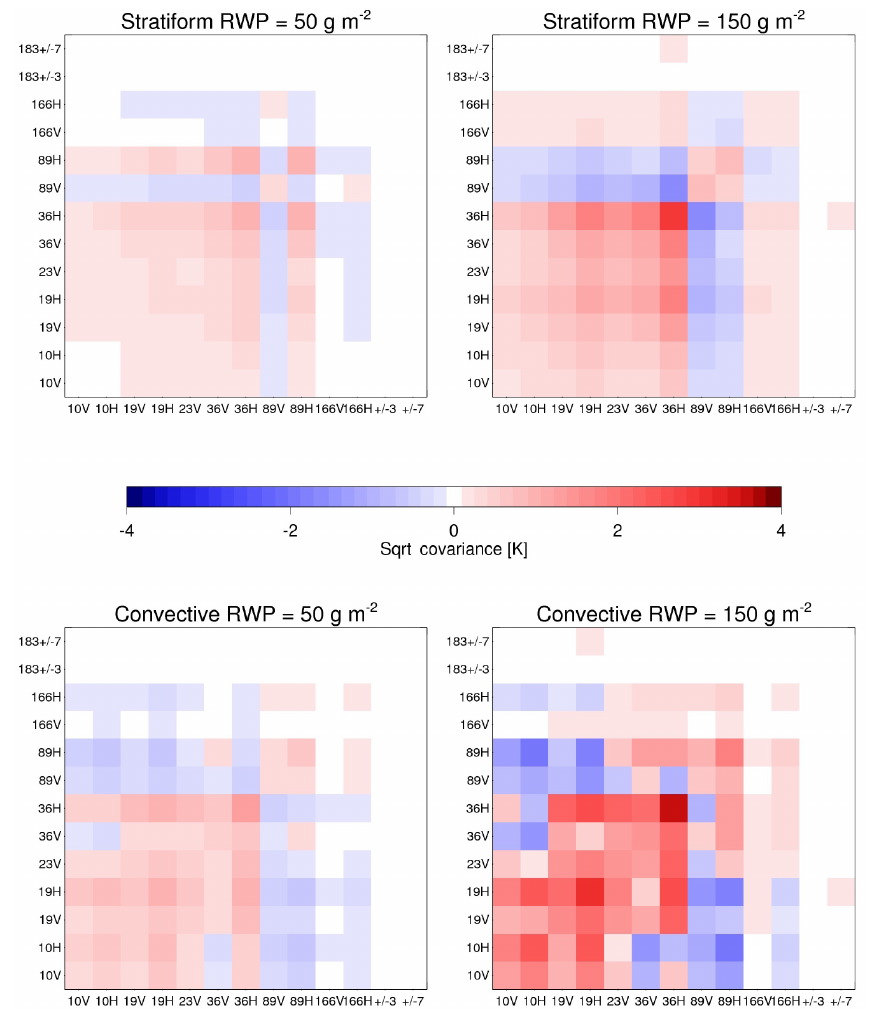
Figure 5. Error covariances due to DSD variability observed at extratropical ocean sites. The RWP values of 50 and 150gm − 2 are nom- inal. Covariances are in units of K, with negative covariances given as − p | S y | , to aid interpretation. These error covariances make up S y, rain ( RWP ) , a constituent of the total S y from Eq. (3), described later in Sect.